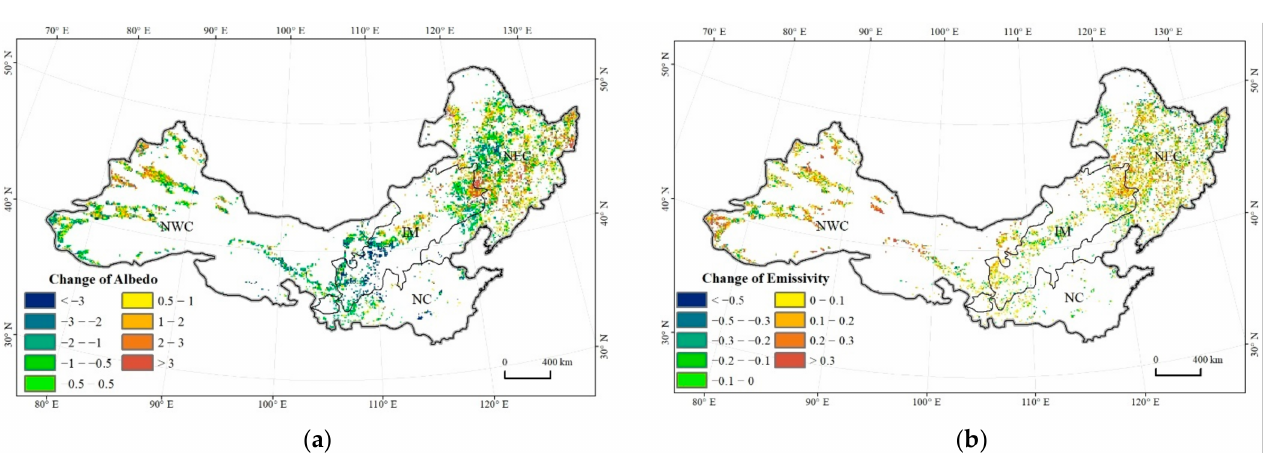
Figure 4. Annual changes of albedo ( a ) and emissivity ( b ) in the cropland expansion regions during 2000–2015.